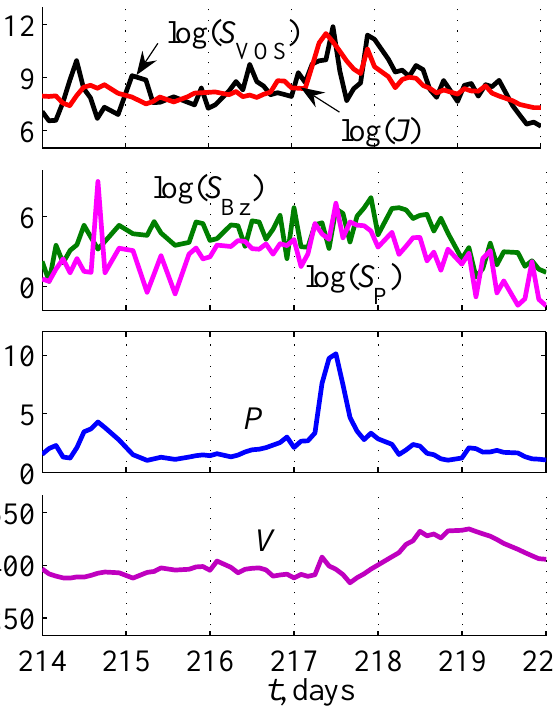
Fig. 11. Examples of variations of S VOS (black, upper) and J (red,upper), S P (green, second) and S Bz (magenta, second), P (third), and V (lower) for the interval 8 June 1998–13 June